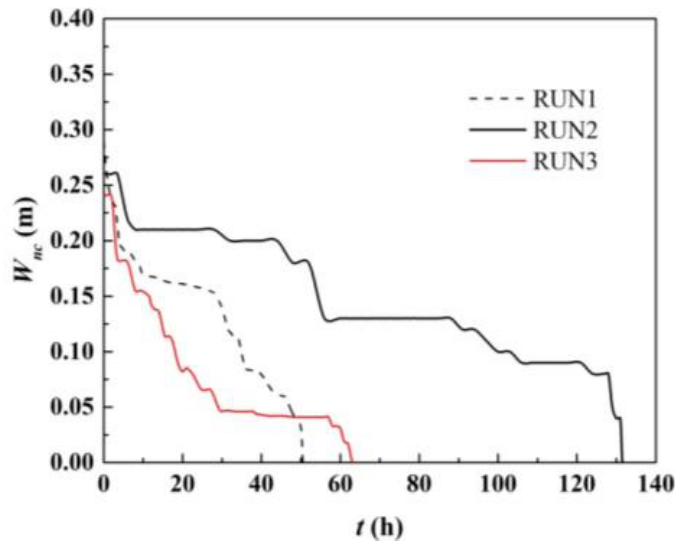
Figure 4. Temporal variations in the neck width W nc before cutoff.